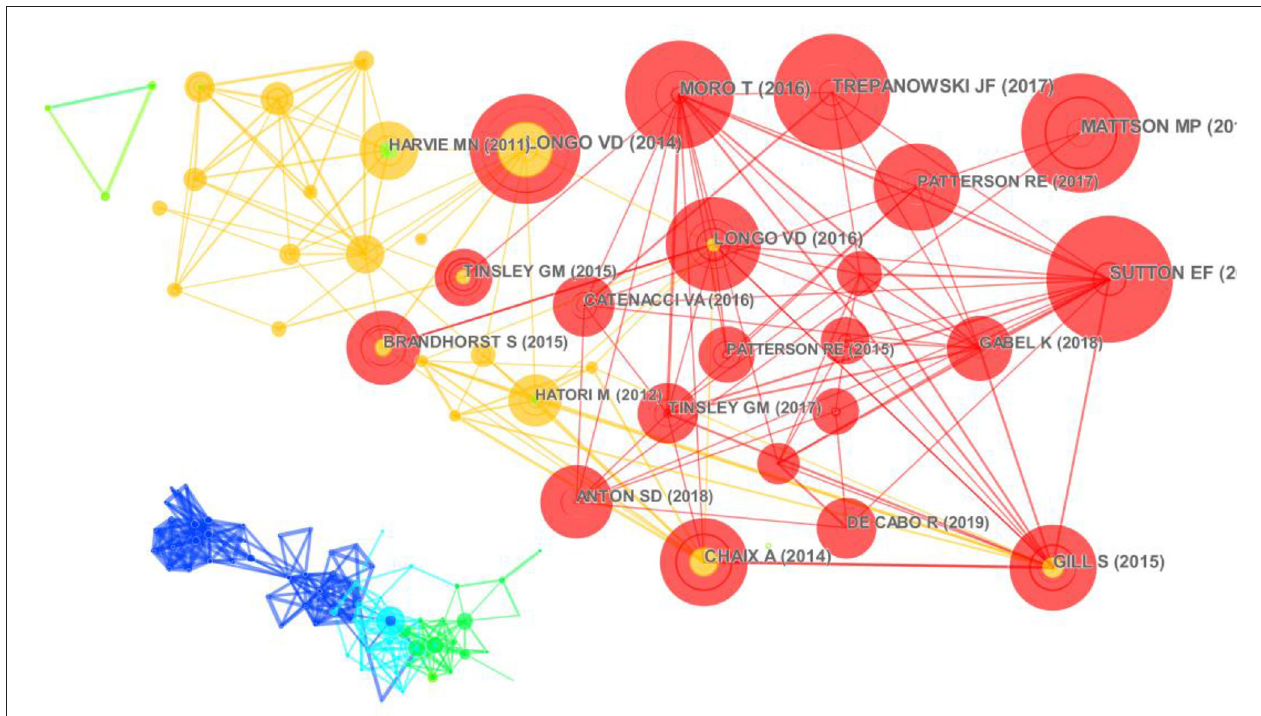
FIGURE 7 | Co-citation analysis mapping of literature related to intermittent fasting.